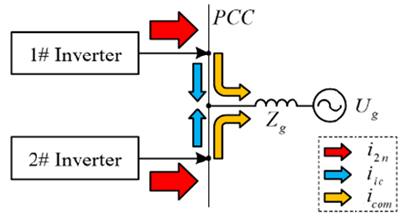
Figure 7. Interactive current and common current for paralleled inverters.